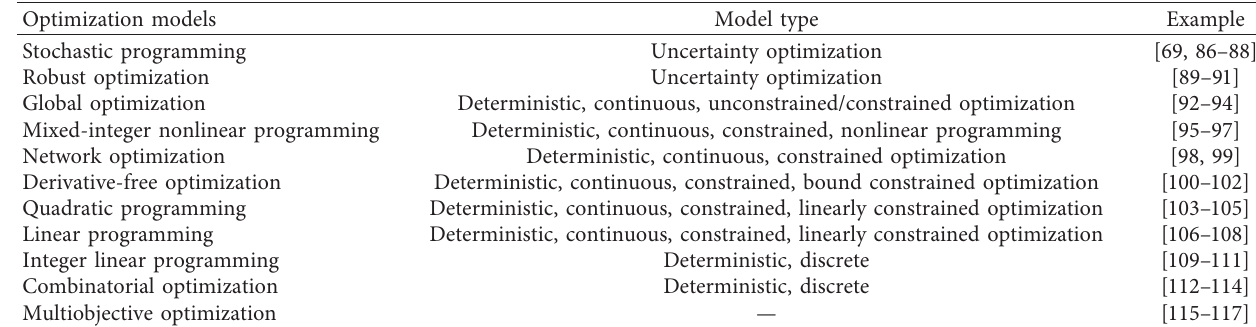
Table 6: Types of optimization problems.